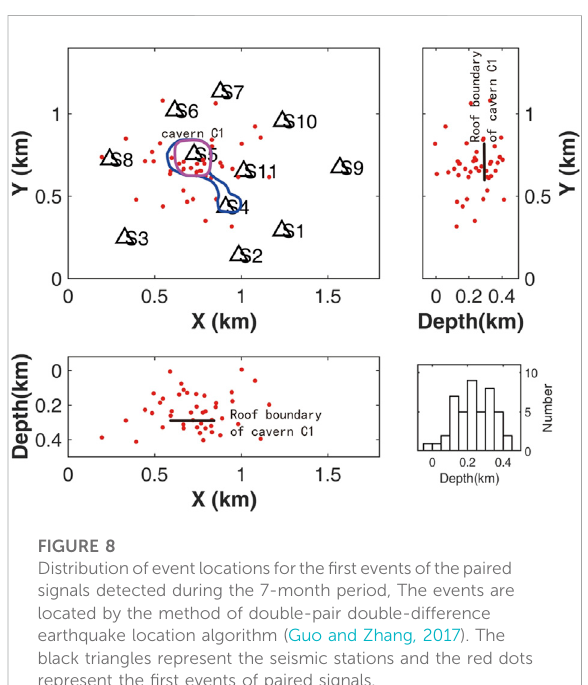
FIGURE 8 Distributionofeventlocationsforthe fi rsteventsofthepaired signals detected during the 7-month period, The events are located by the method of double-pair double-difference earthquake location algorithm (Guo and Zhang, 2017). The black triangles represent the seismic stations and the red dots represent the fi rst events of paired signals.